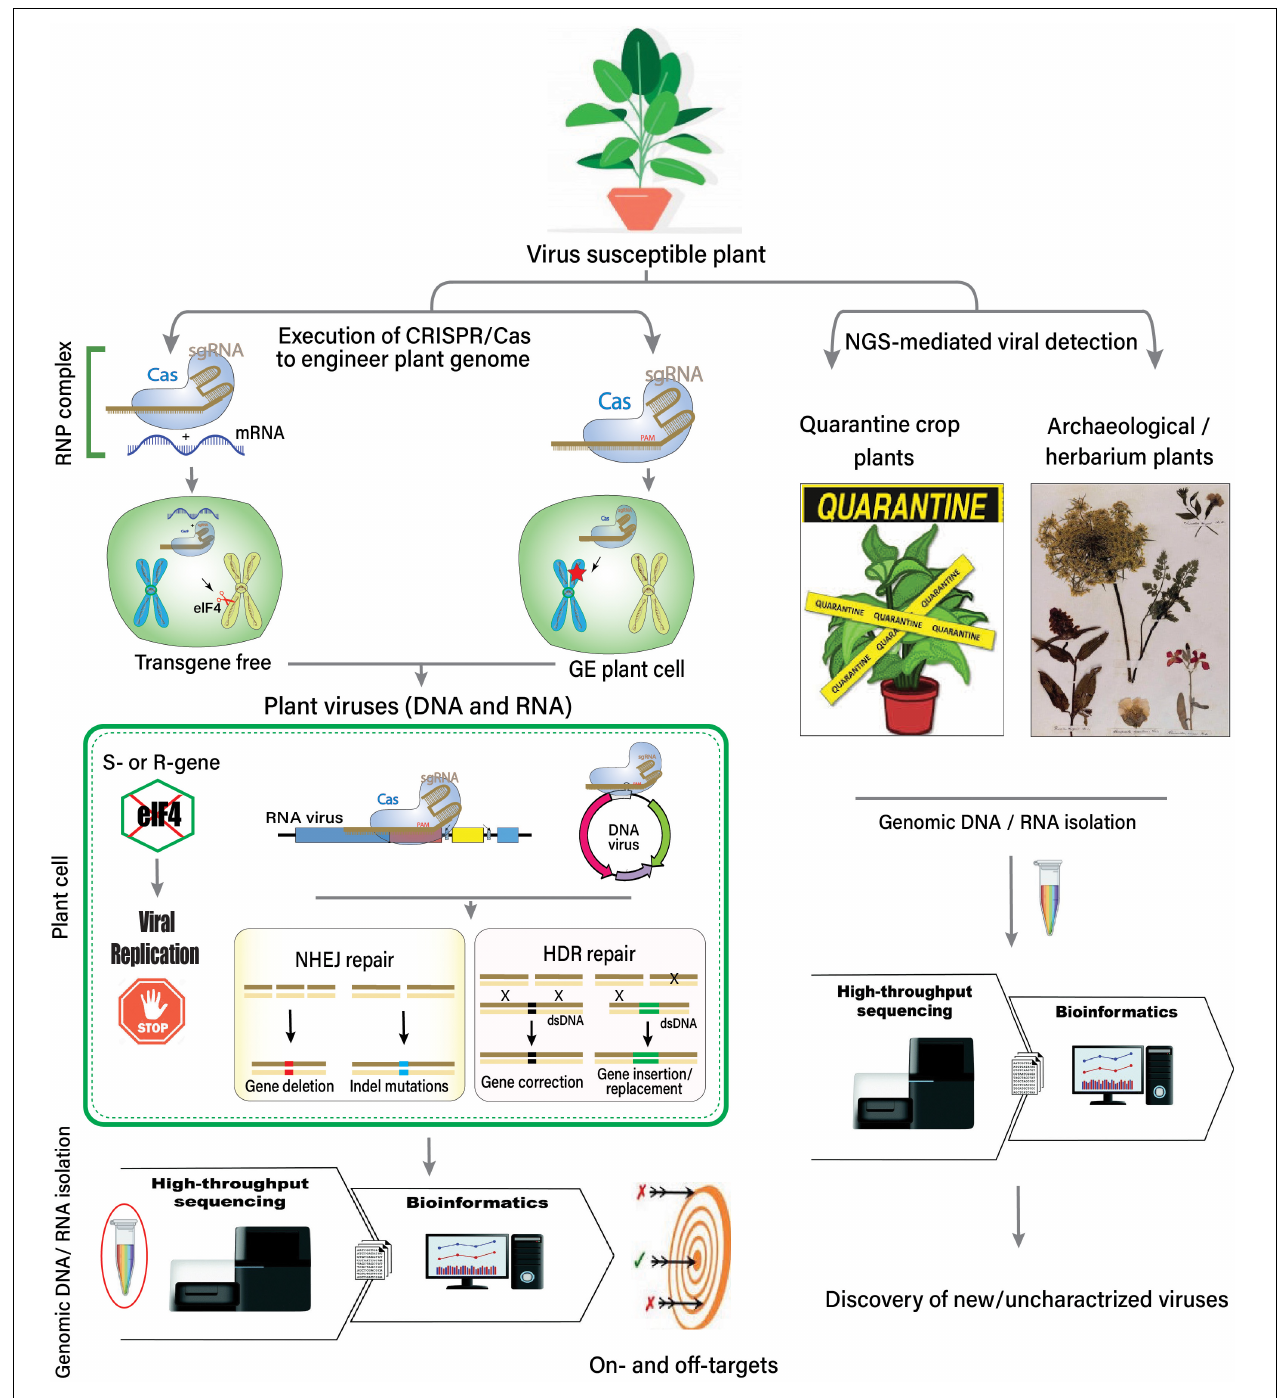
FIGURE 2 | Overview of the host–virus interaction, the role of HTS, CRISPR-Cas system, and the discovery of unknown